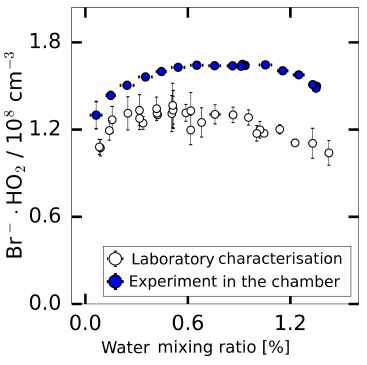
Figure 5. The background HO 2 measurement in the SAPHIR cham- ber derived during the humidification of the clean chamber and the background measured during the laboratory calibration supplied with humidified synthetic